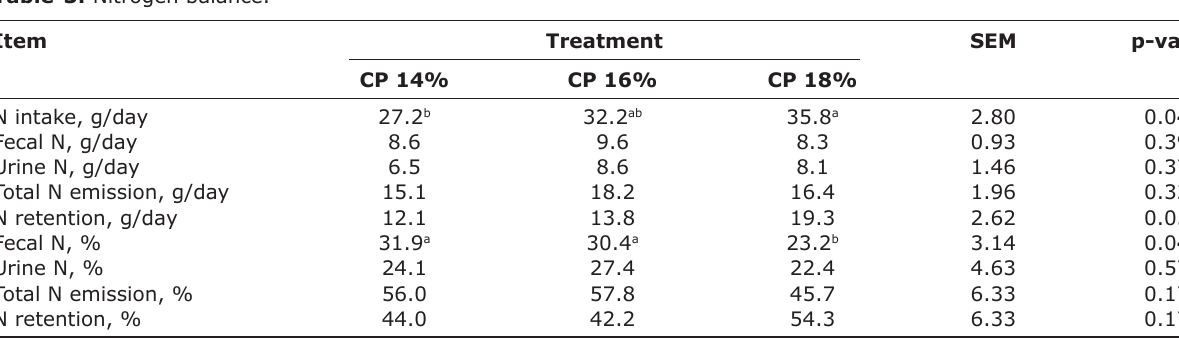
Table-3: Nitrogen balance. Item